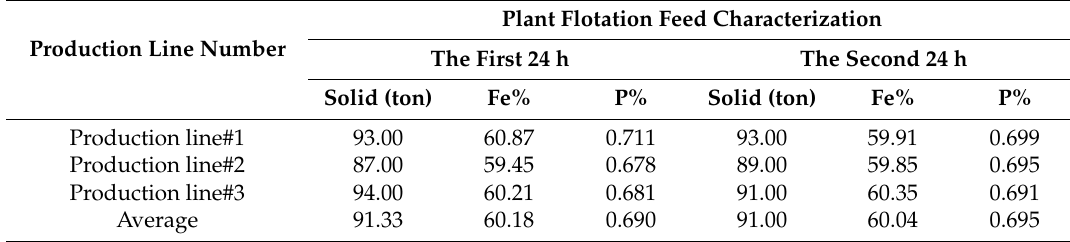
Table 3. Characterization of flotation feed of the plant during the industrial experiments.